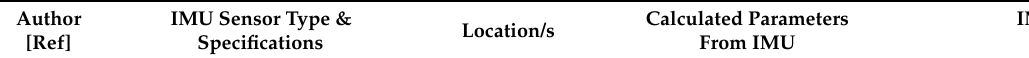
Table 2. Study parameters and outcome